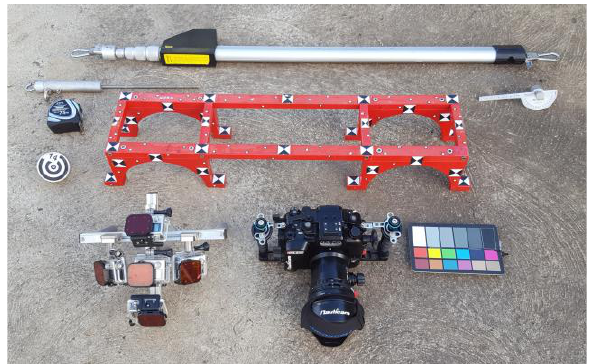
Fig.2: Various devices for underwater measurements of GCPs and for image acquisition. From top to bottom: Graduated telescopic bar for distance measurements; GCP pole with attachment for distance measurements; measurement tape for long distances; calibration frame; device for coarse angular measurements; signalized photogrammetric GCP target, to be fixed to the pole; 5-head GoPro camera system (not used in this paper); Lumix camera with wet lens dome port; chart for color calibration